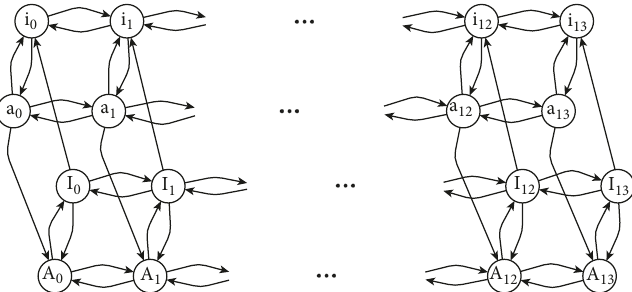
Figure 4: Conformational switch model of NFAT1 [38]. Lower case letters denote the protein located in the cytoplasm while upper case letters refer to the protein in the nucleus. 𝑎 𝑗 , 𝐴 𝑗 and 𝑖 𝑗 , 𝐼 𝑗 for 𝑗 = 0, ...13 denote the active and inactive proteins, respectively. Lower indices denote the number of phosphorylated